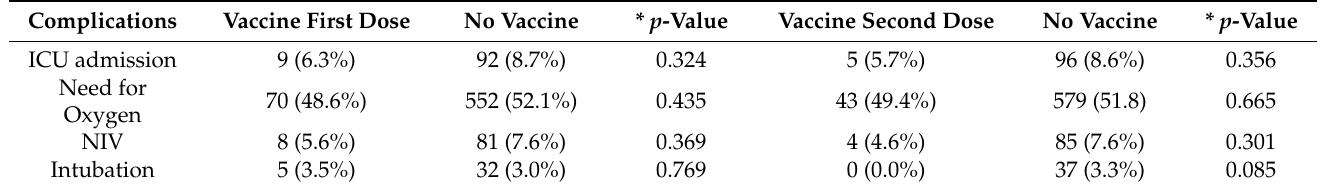
Table 3. Vaccination dose and admission to the ICU, oxygenation requirement, NIV, and